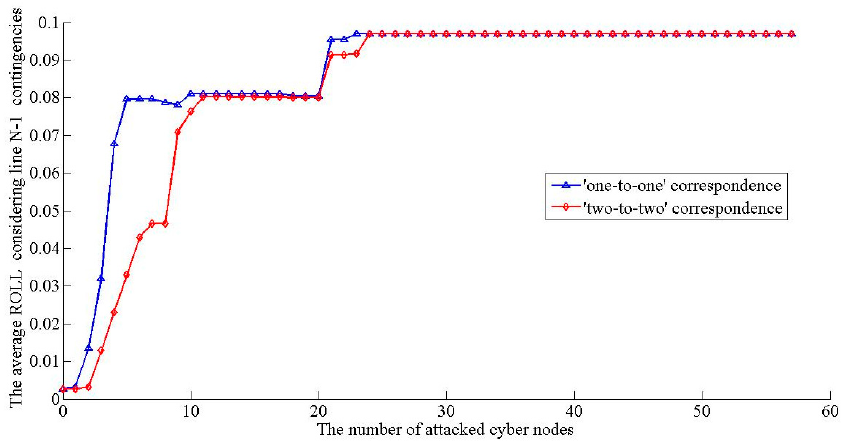
Figure 6. Adding additional cyber-physical interconnections, the average ROLL of CPPS considering line N − 1 contingencies.